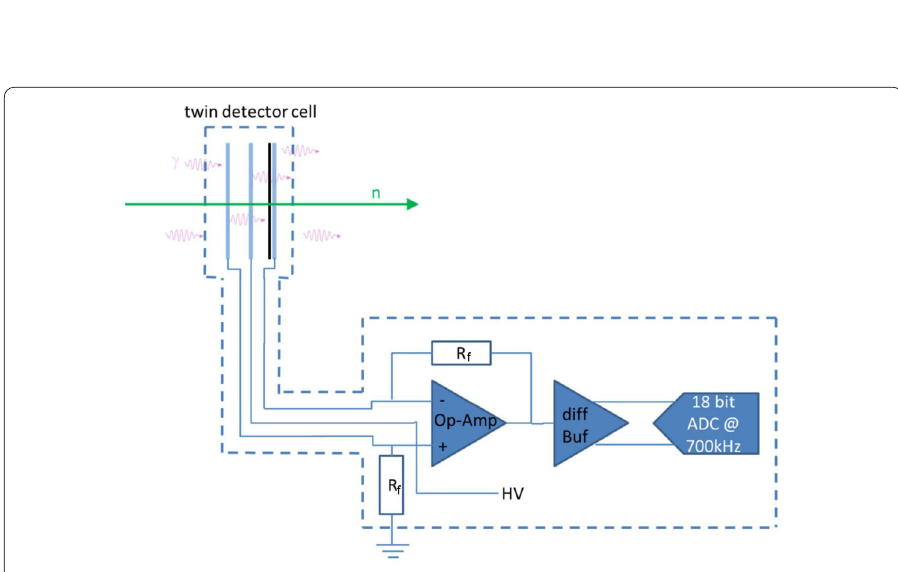
non-inverting input. Since both current signals are fed through the same impedance, in case the signals are the same in the neutron and the reference chambers, the total signal is zeroed. It is the differential signal that acts as the total output of the